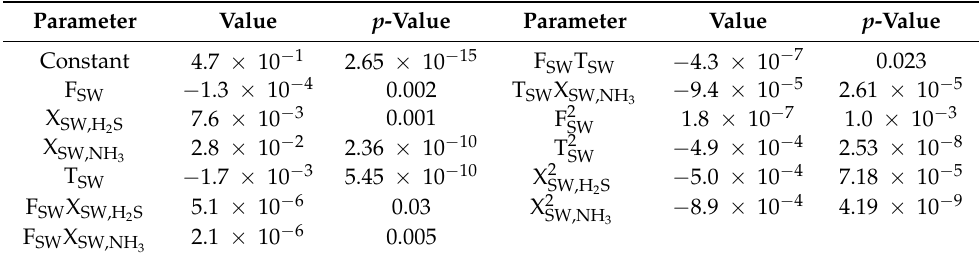
Table 2. The parameters of the minimum reboiler duty